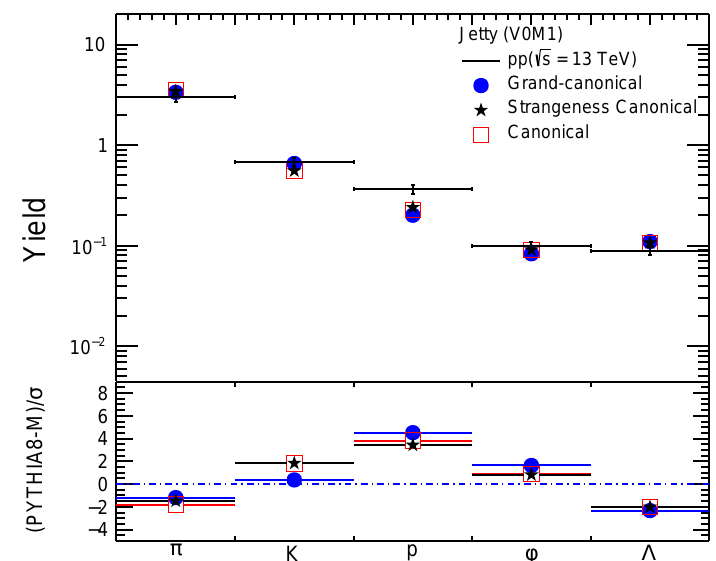
Figure 5. The upper panel shows the comparison of the identified particle yields in pp collisions at √ s = 13 TeV for jetty events at the highest multiplicity class with the thermal model using grand canonical, strangeness canonical and canonical ensemble. The lower panel shows the deviation from fit results.